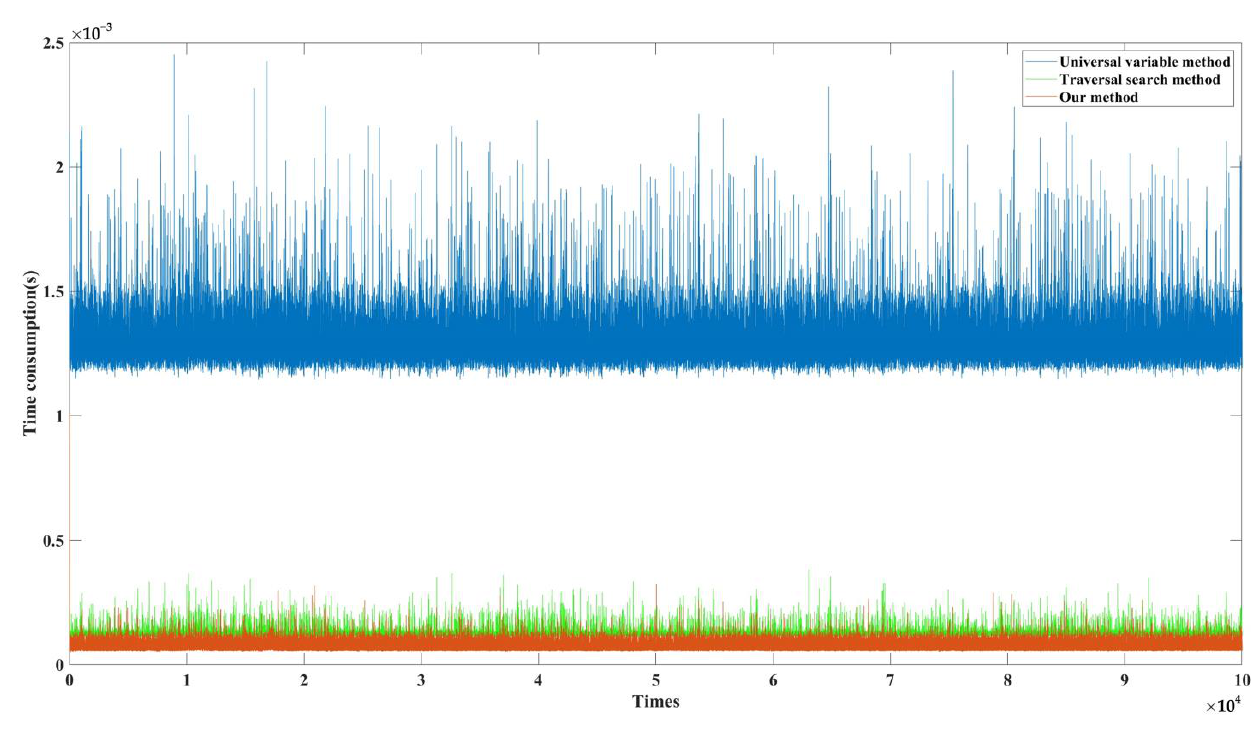
Figure 6. Time consumption of each method.